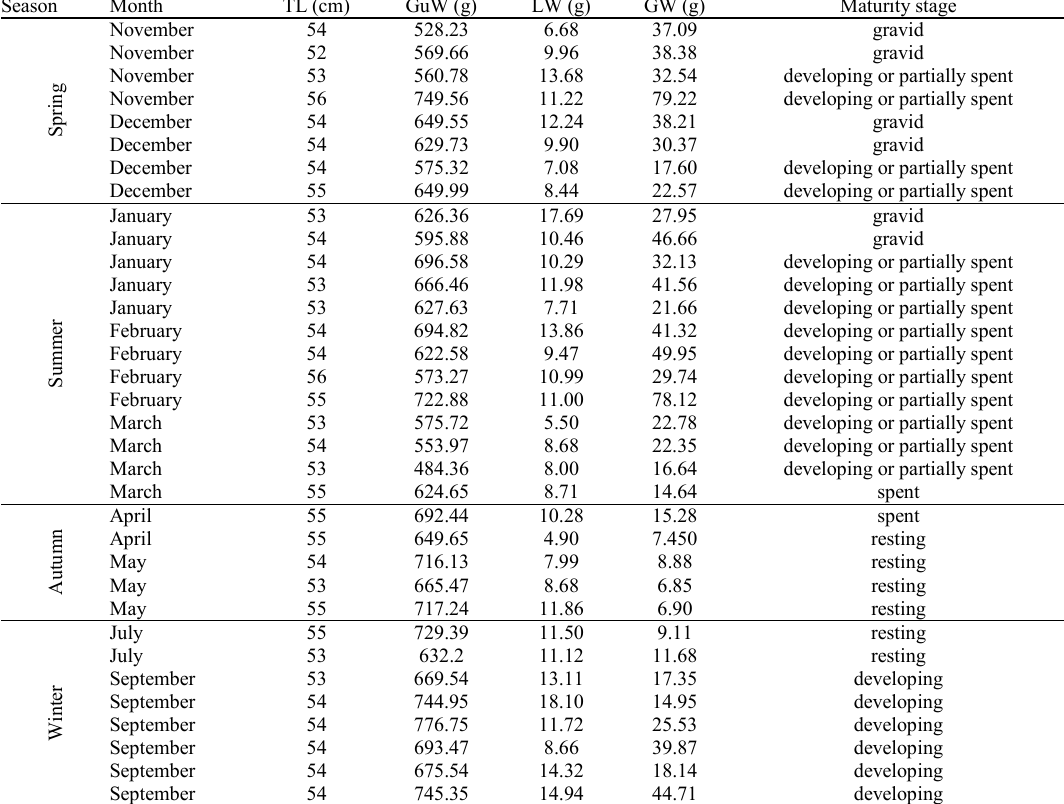
Table 1. Morphometric variables and maturity stages of Percophis brasiliensis females collected from commercial landings during different seasons. TL: total length, GuW: gutted weight, LW: liver weight, GW: gonad weight. Season Month TL (cm) GuW (g) GW (g)